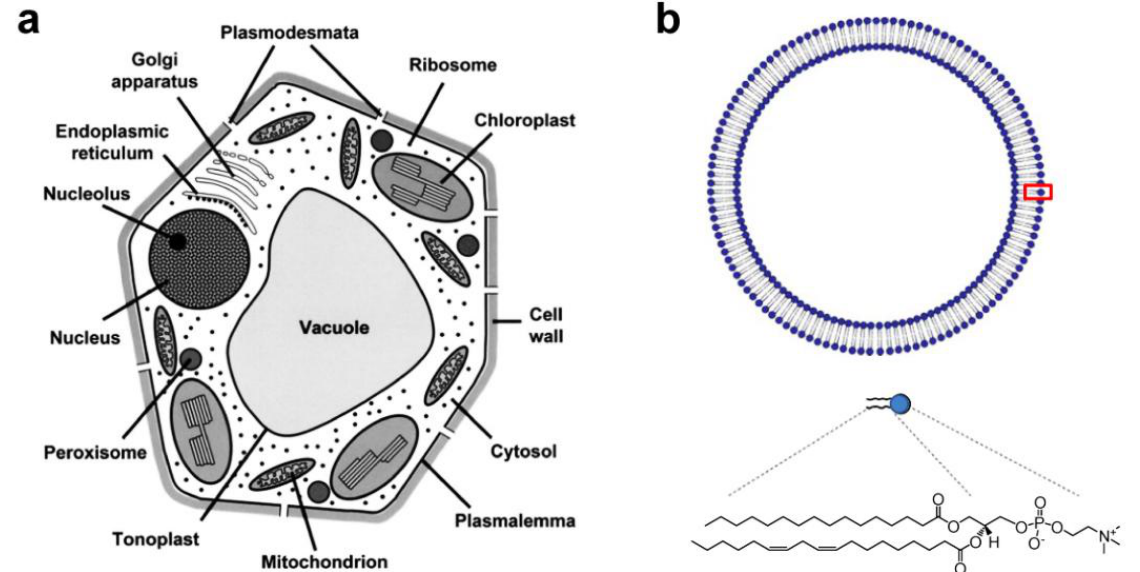
Figure 1. ( a ) Schematic diagram of a plant cell showing the main organelles and compartments (Reprinted with permission from [2]. Copyright 2007 Oxford